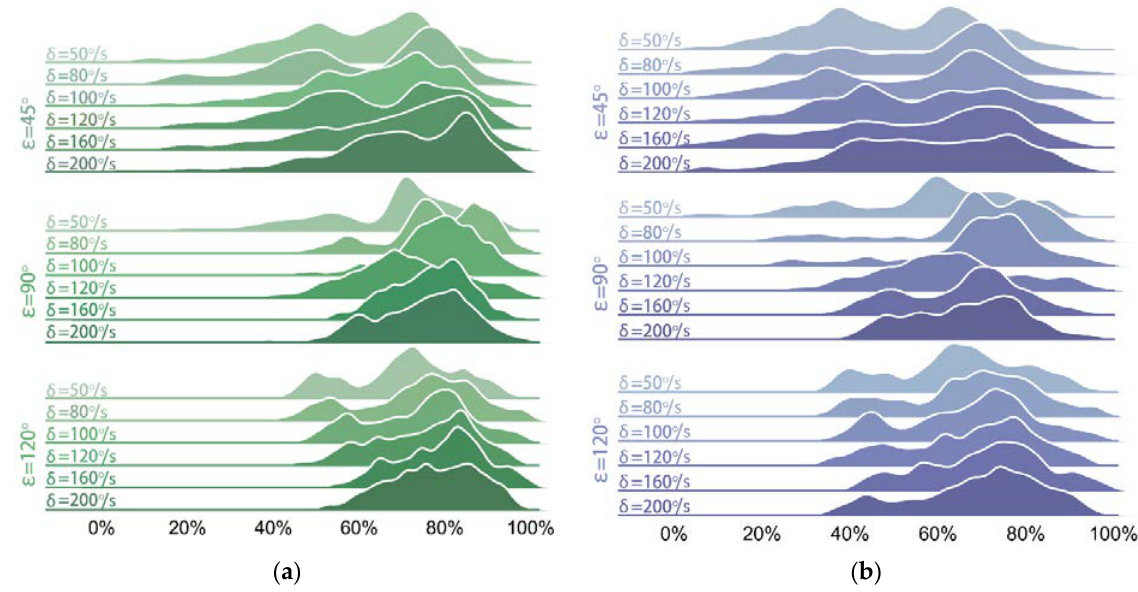
Figure 8. Distributions of balance efficiencies of EG under 18 conditions: ( a ) η CG ; ( b ) η PF .